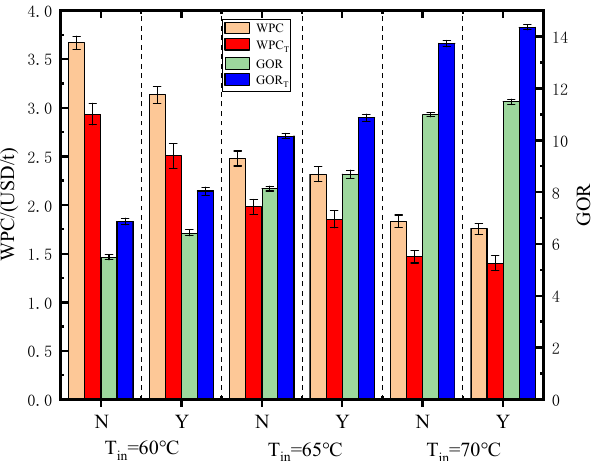
Figure 22. Water production cost and gained output ratio under different conditions with error bars. N—without copper meshes; Y—with copper meshes.